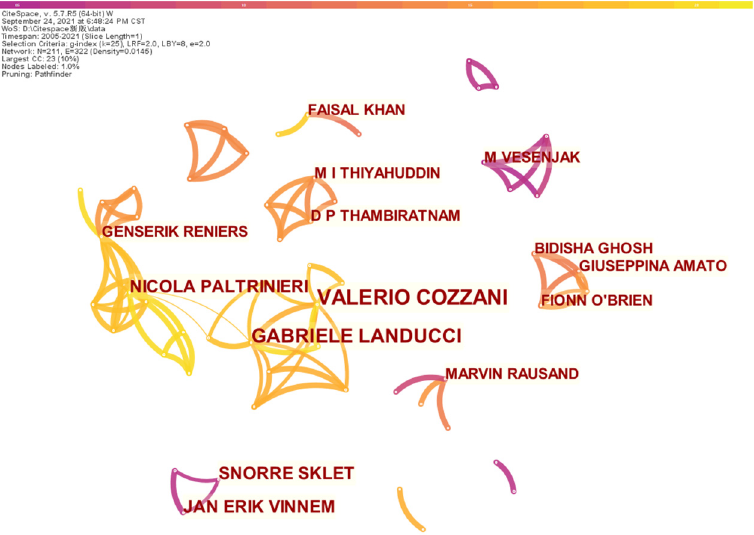
Figure 4. Illustration of scholar collaboration by co-authorship analysis.